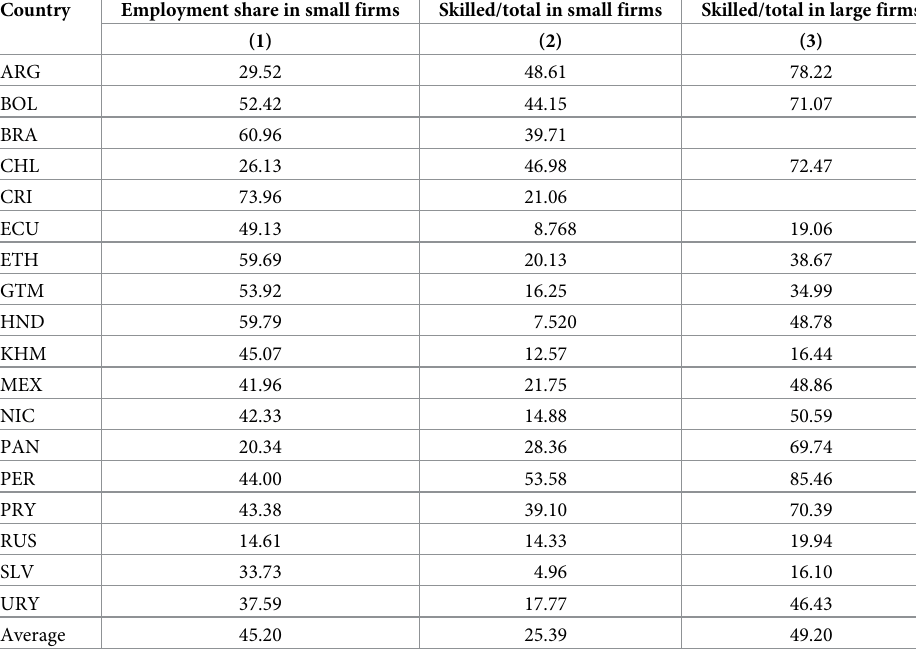
Table 8. Share of employment in small and large firms by